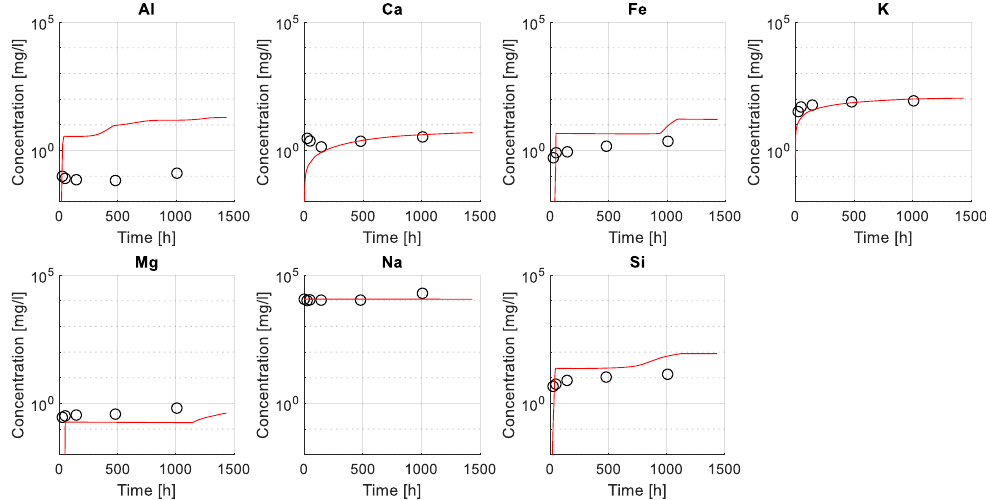
Figure 7. Comparison between numerical and experimental results (ICP-OES) of elemental concentration for selected ions in the exposure solution. Modeled results (lines) and experimental values (markers) are presented in mg/L in a logarithmic scale along the experiment time (presented in a linear scale).